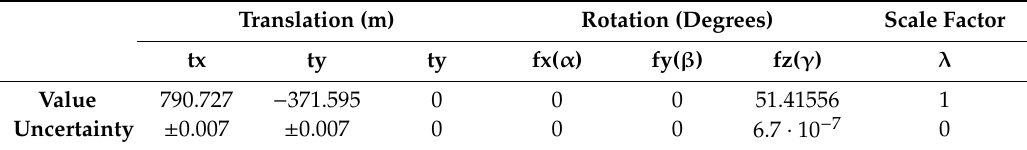
Table 3. Tested points before transferred in the bridge system.